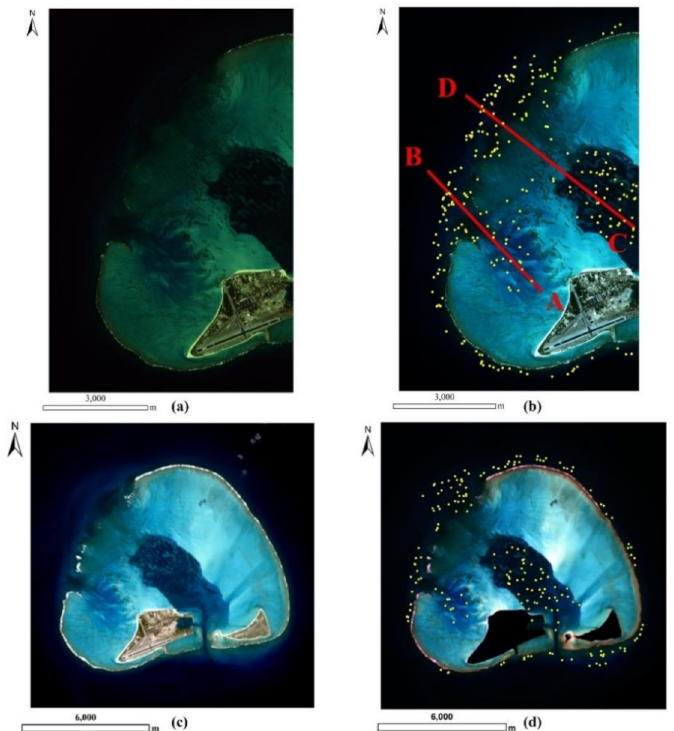
Figure 6. True-color remote sensing images of Midway Island in 2016 before ( a , c ) and after ( b , d ) the preprocessing. ( a , b ) WorldView-2 image; ( c , d ) Landsat image; yellow points in ( b , d ) are the distribution of self-inferred points (SIPs) selected before inverting the bottom reflectance in Section 3.4; red lines (A − B and C − D) in b are used to indirectly check the bottom reflectance inversion results in Section